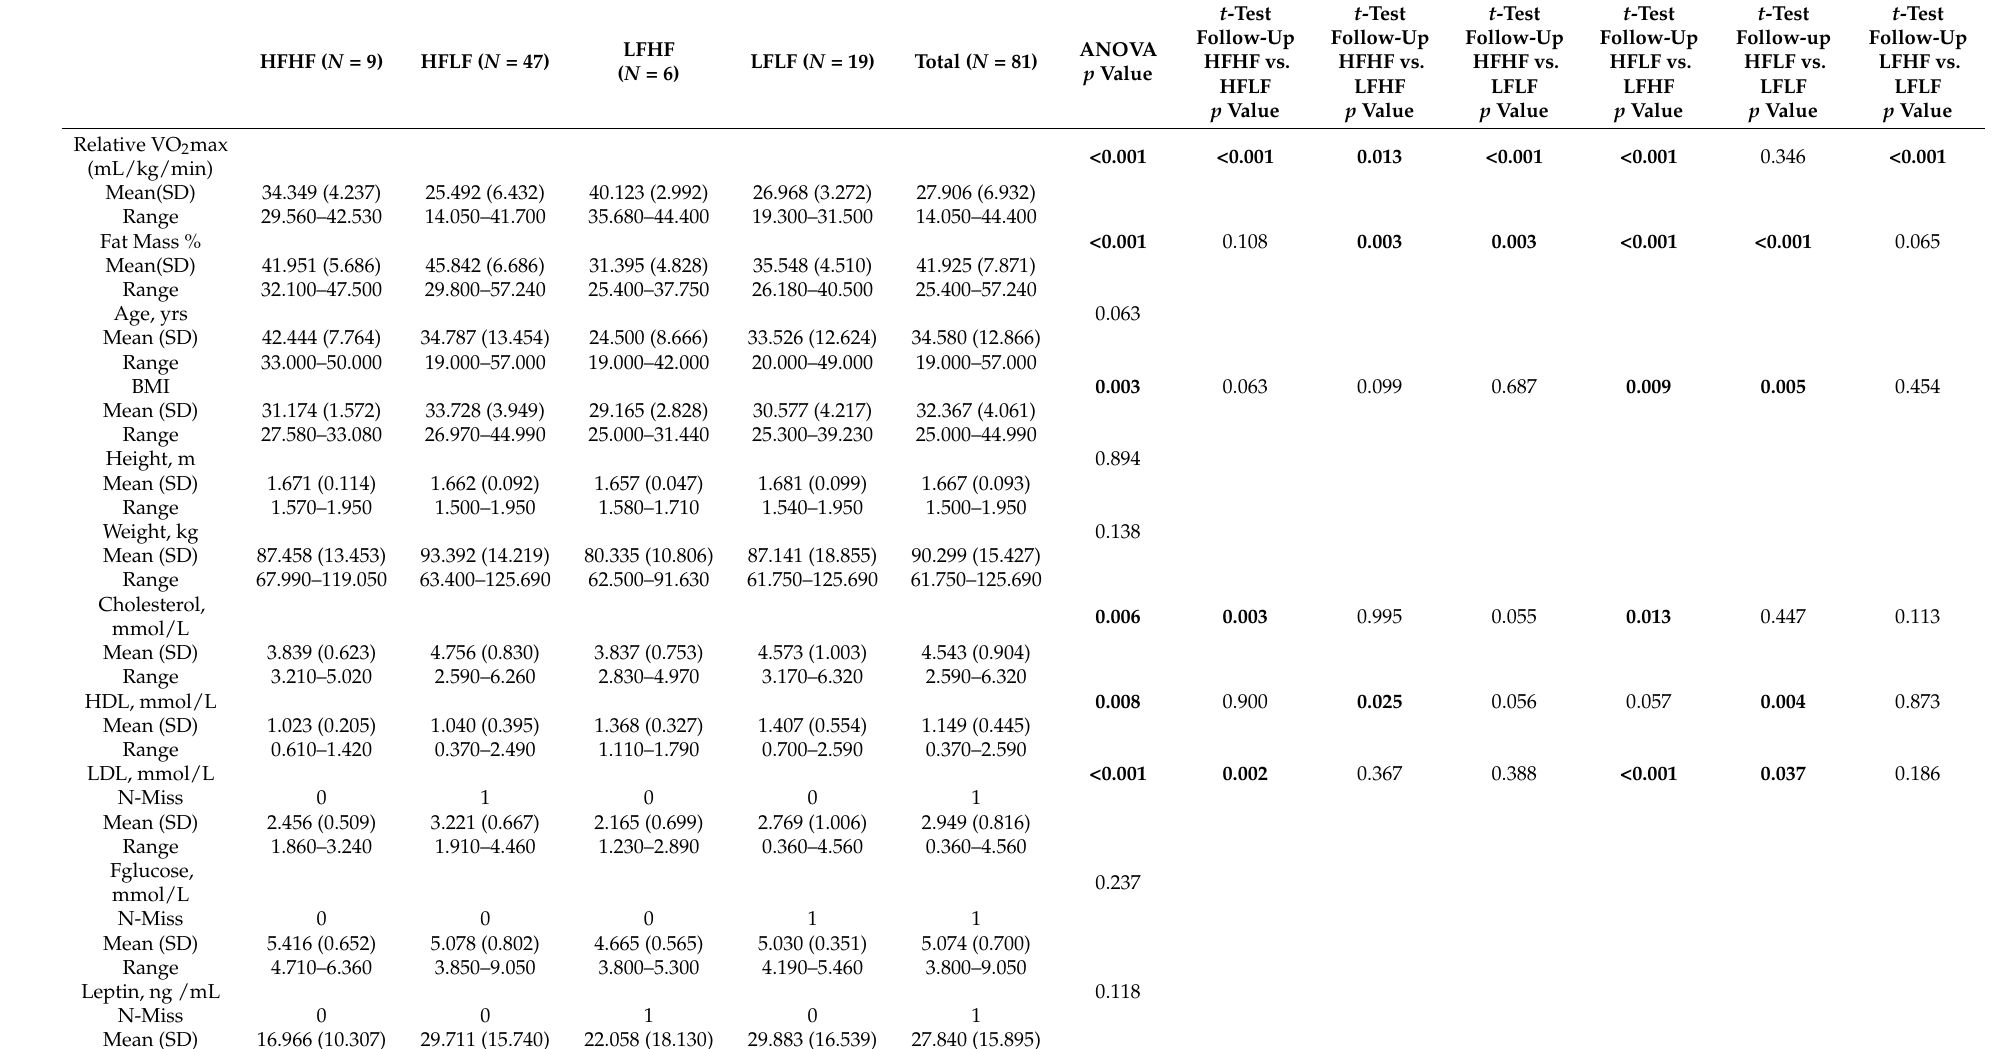
Table 3. Descriptive Statistics of Database, difference analysis and follow-up